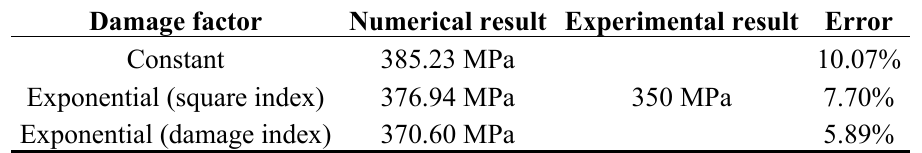
Table 4. Comparison of OHT strengths from numerical and experimental